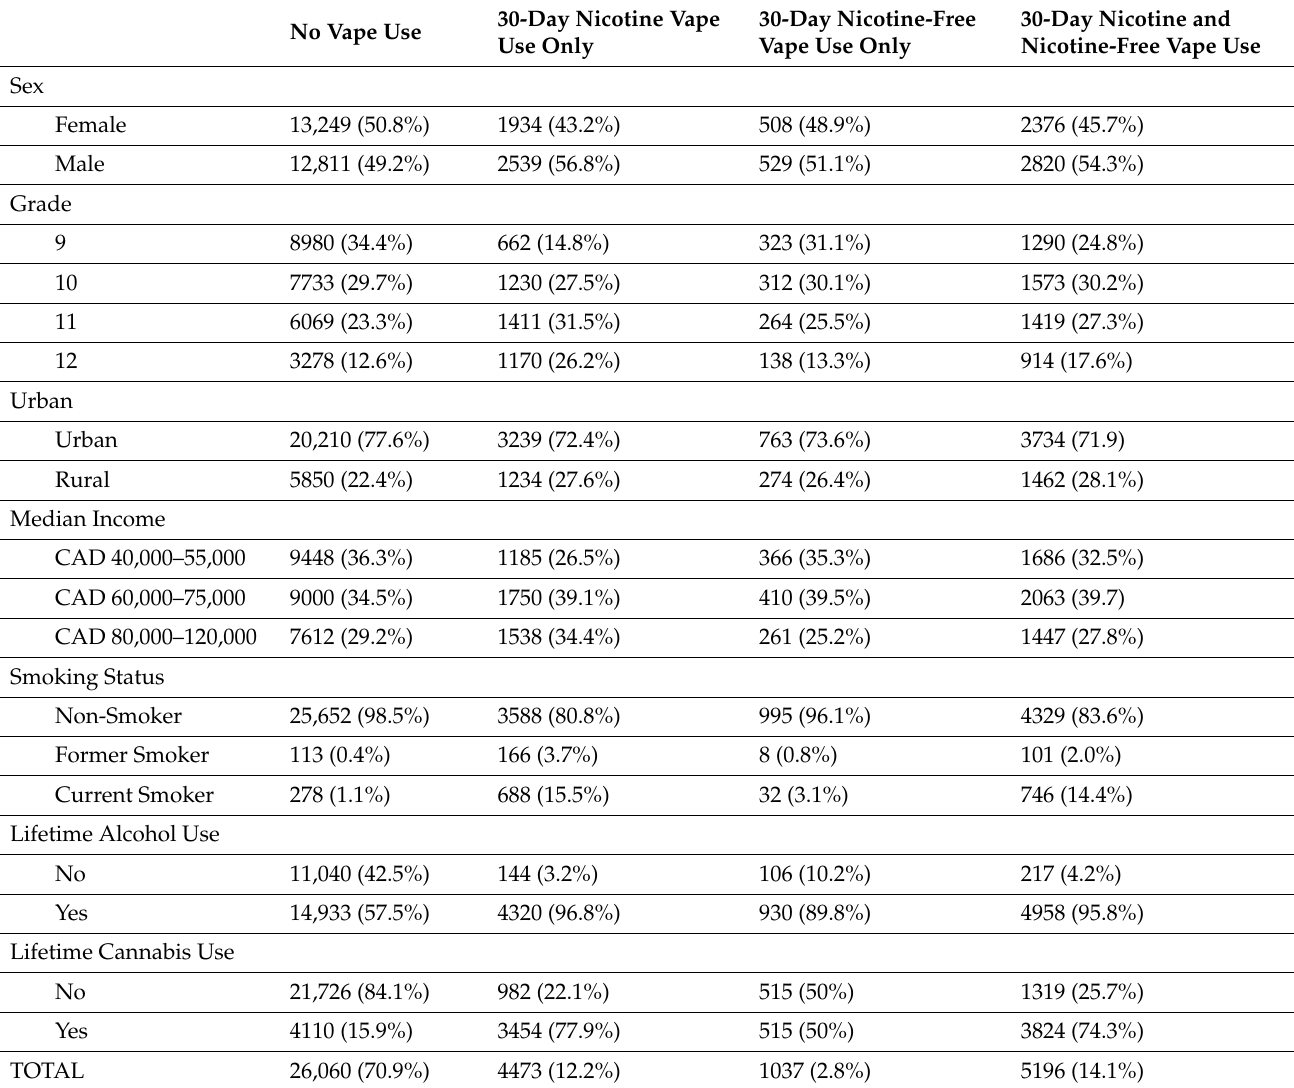
Table 1. Sample characteristics (overall and by vape status).